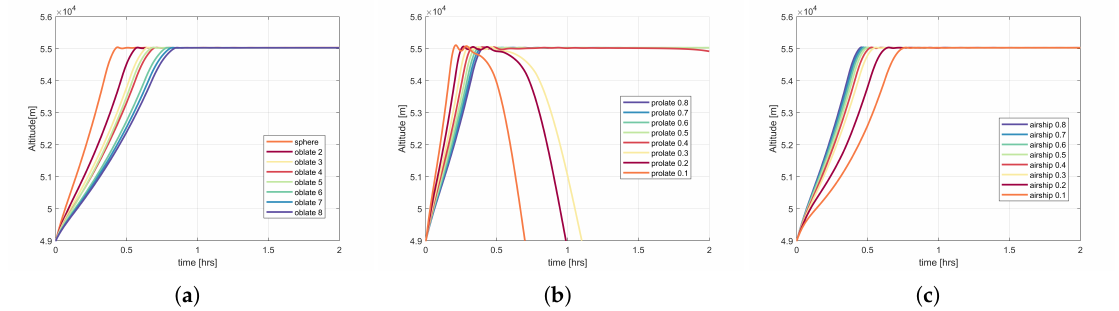
Figure 5. Altitude variation of the ZP balloons for different shapes with varying fineness ratio f in order to find the stable fineness ratio on Venus: ( a ) oblate ( f : 2–8) ( b ) prolate (0.1–0.8) ( c ) airship